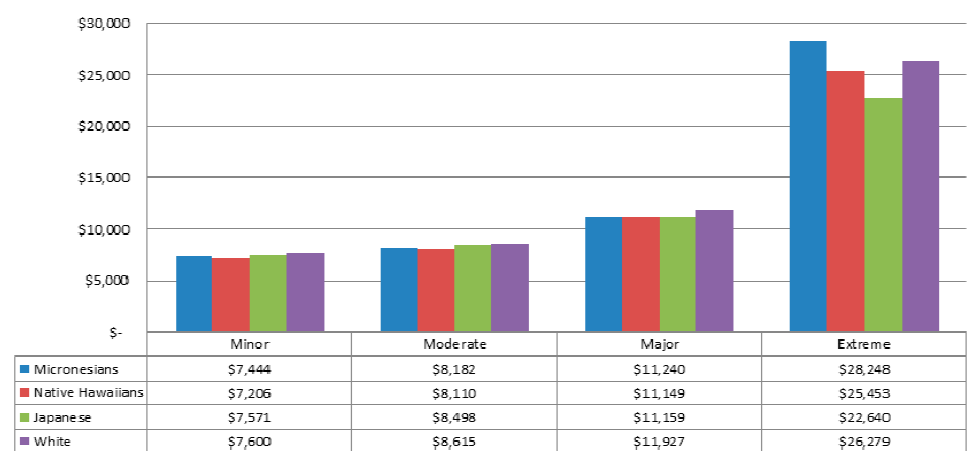
Figure 3. Median Costs in US Dollars by Race/Ethnicity and Severity of Illness Levels (Minor, Moderate, Major, Extreme) from 2010 to 2012 Hawaii Health Information Corporation